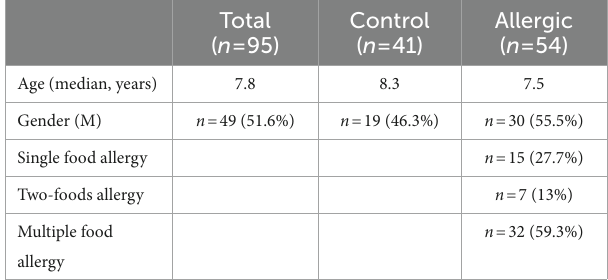
TABLE 1 Age, sex and allergy distribution of children with and without food